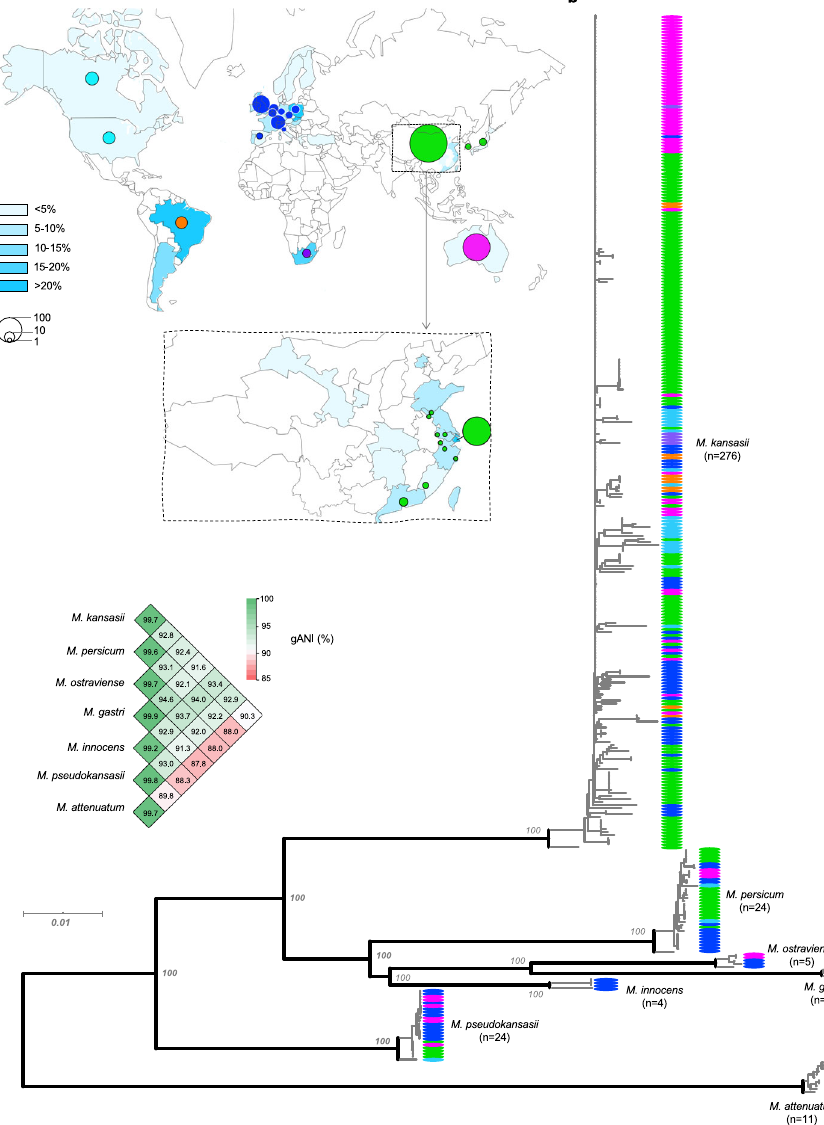
Fig. 1 Global diversity of the M. kansasii complex. a Geographical distribution of the 358 isolates in the study. The gradient blue colors indicate the prevalence of M. kansasii among NTM disease. b Core genome-based maximum-likelihood phylogeny of the 358 isolates. The colors of the terminal nodes correspond to the geographical origin of individual isolates, as denoted by the circles in ( a ). c Pairwise genomic average nucleotide identity (gANI) within and between the M. kansasii complex species. Source data are provided as a Source Data fi